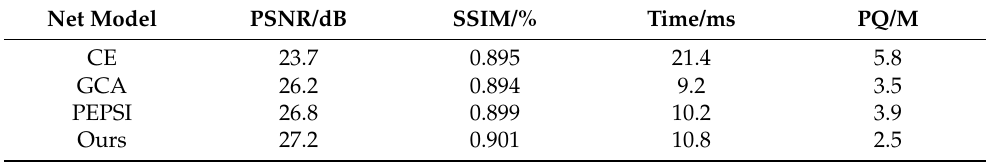
Table 4. Performance of the different inpainting methods for square masked images.